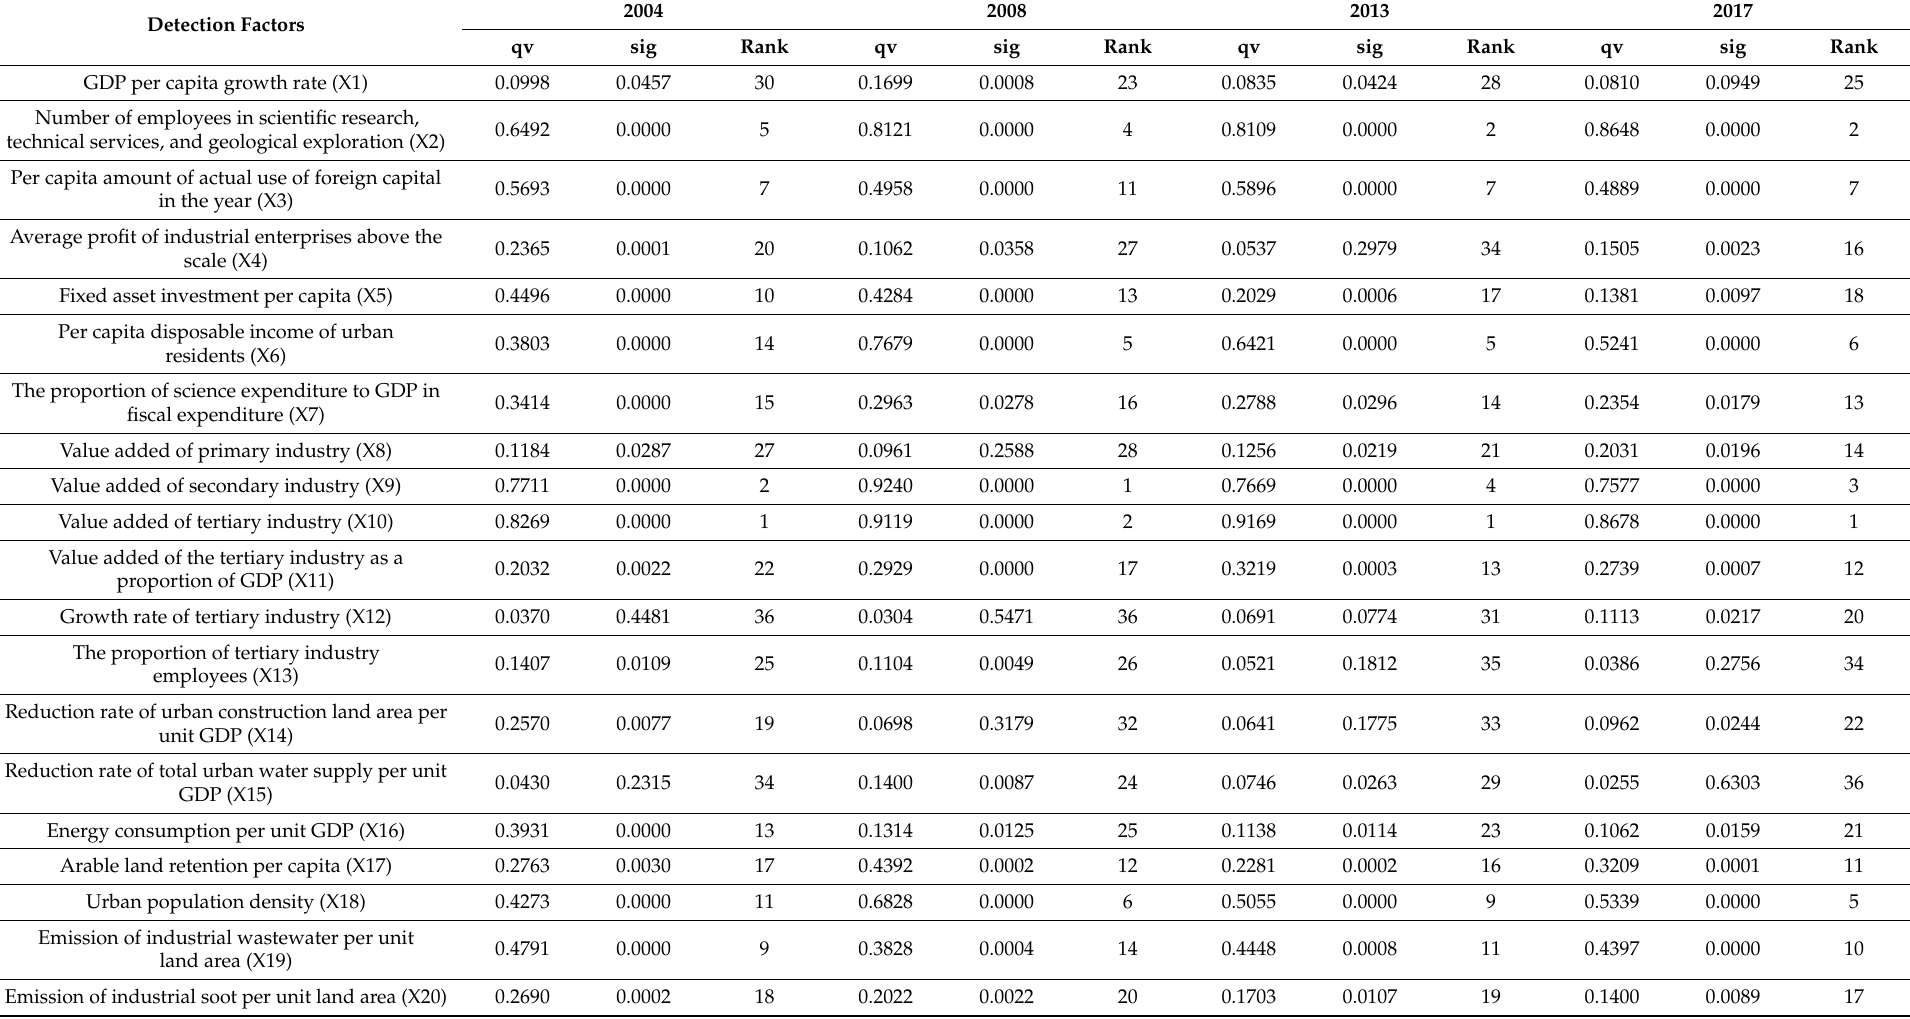
Table 3. Detection results for green development level